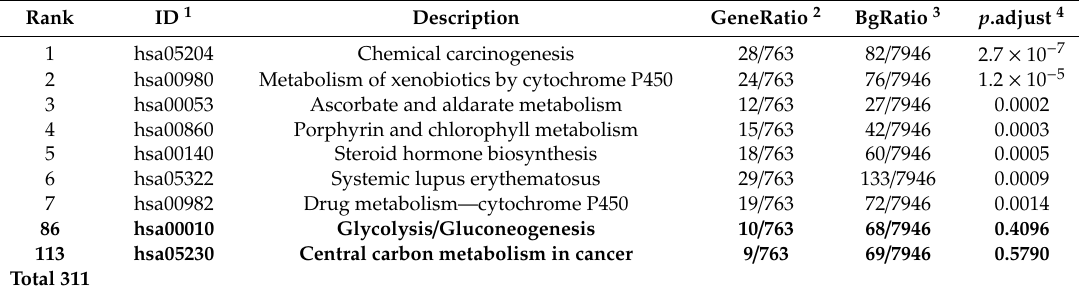
Table 2. Downregulated signaling pathways upon HGF stimulation in Detroit 562. Ranking based on adjusted p -value ( p .adjust). Results of the first seven pathways on the list and of two pathways of interest are shown. Only genes that are part of at least one of the pathways listed in KEGG and that show a di ff erence in expression of ≤ − 0.4 (log 2 fold change) and p adj < 0.1 are